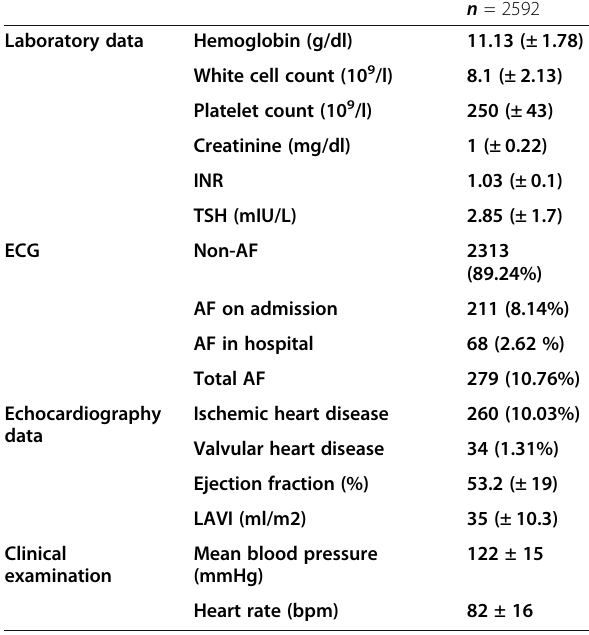
Table 2 Baseline laboratory and ECG data of de novo AF patients presented with acute ischemic CVS patients